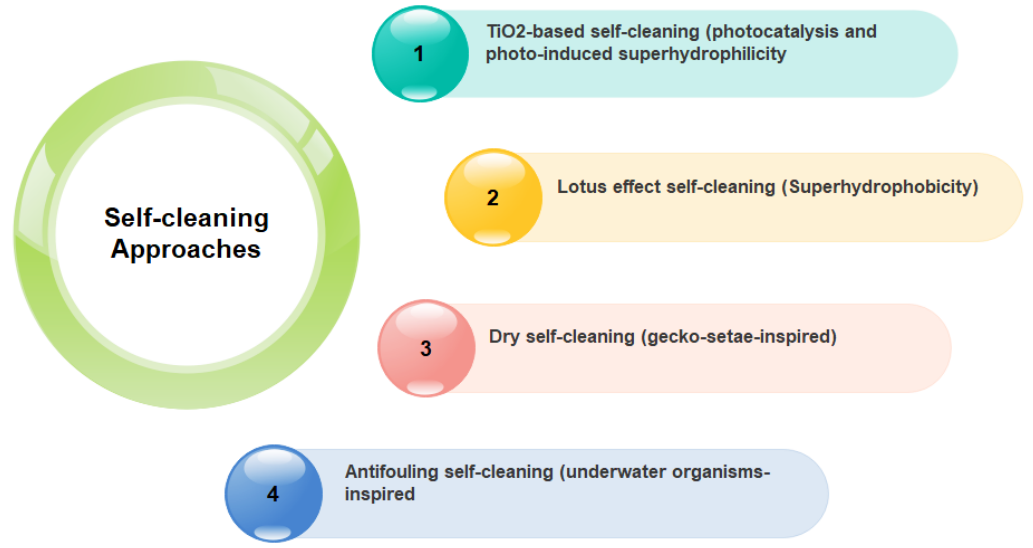
Figure 7. Self-cleaning approaches in materials.